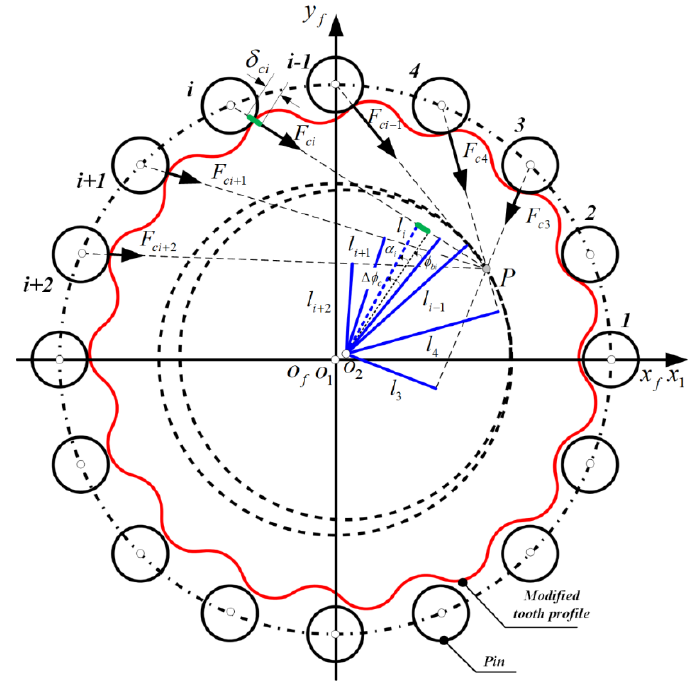
Figure 8. Coordinate systems for loaded tooth contact analysis.